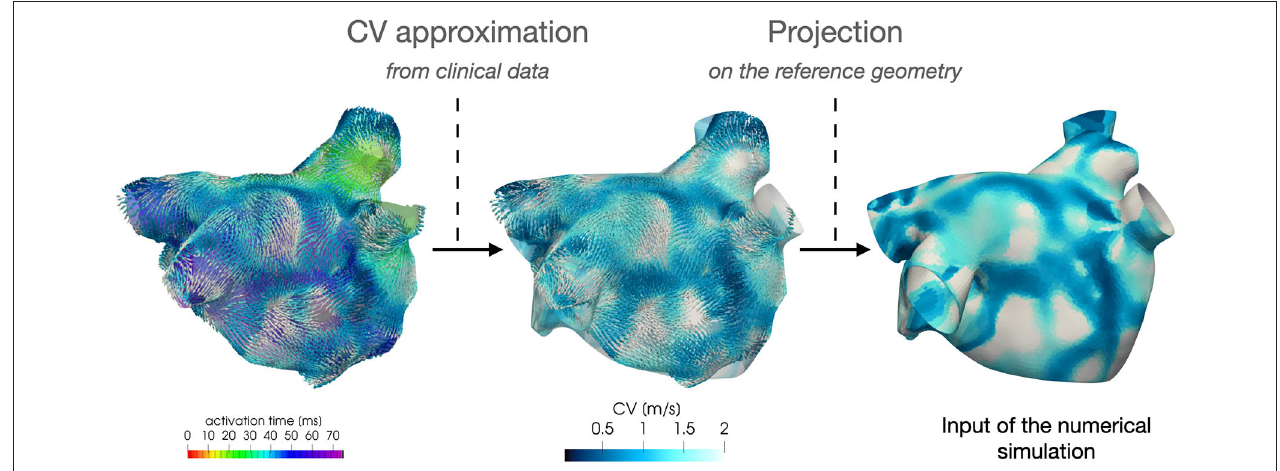
FIGURE 4 | Feeding the model with data: numerical approximation of CV field from patient activation map and its projection onto the computational geometry.